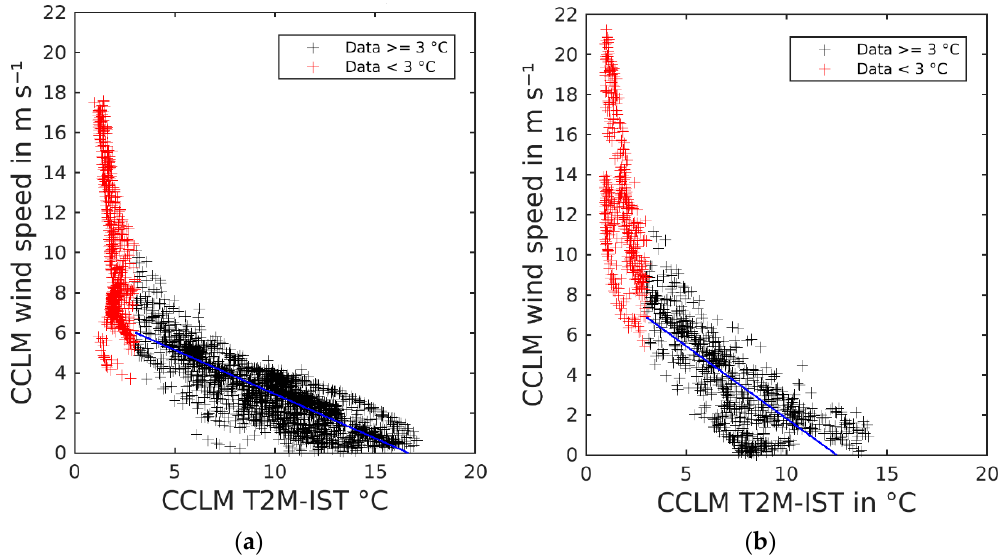
Figure 16. CCLM (T2m-IST) difference as a function of wind speed as for the daily means for 2 May 2014 ( a ) for the ice shelf areas of BIS and Riiser-Larsen (RLIS) and ( b ) for the slope area for the height range 50–500 m (temperatures height-corrected with an adiabatic lapse rate). The blue line indicates the linear fit for (T2m-IST) > 3K.